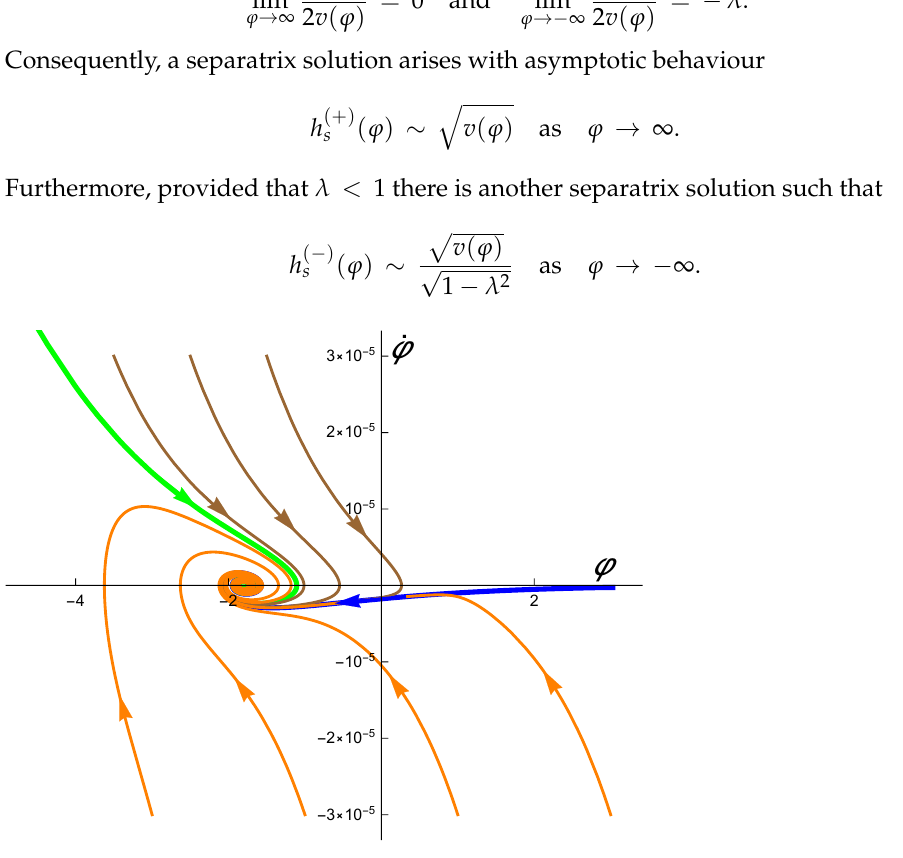
Figure 3. Phase portrait of (9), (11), the blue and green lines stand for the separatrices, the orange lines plot trajectories associated to solutions satisfying (28) while the brown lines corresponds to solutions with asymptotic behaviour (33). The model parameter values are λ = c 2 = 2.5 × 10 − 10